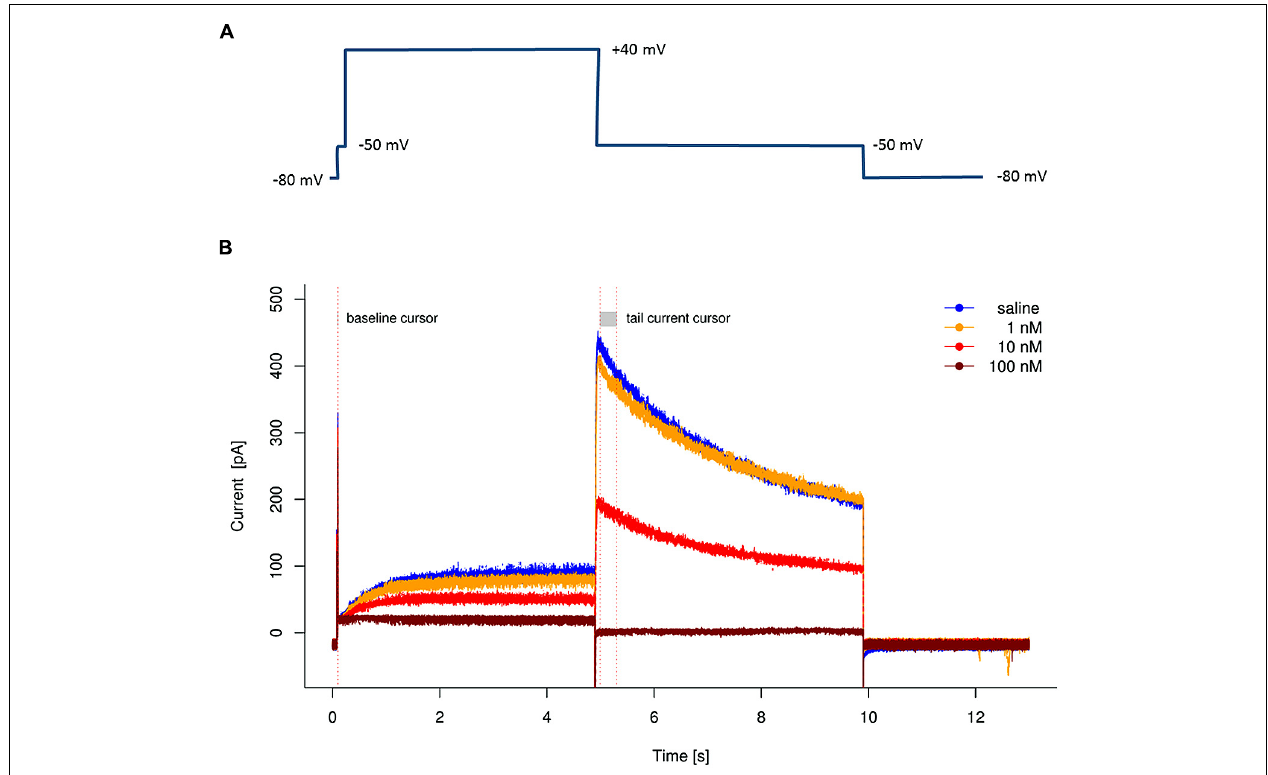
FIGURE 1 | (A) Stimulation protocol for hERG channel measurements. (B) Example of hERG recordings showing the effect of Cisapride. Four representative traces from the same cell are superimposed to visualize the effect of increasing concentrations of the known hERG blocker Cisapride.